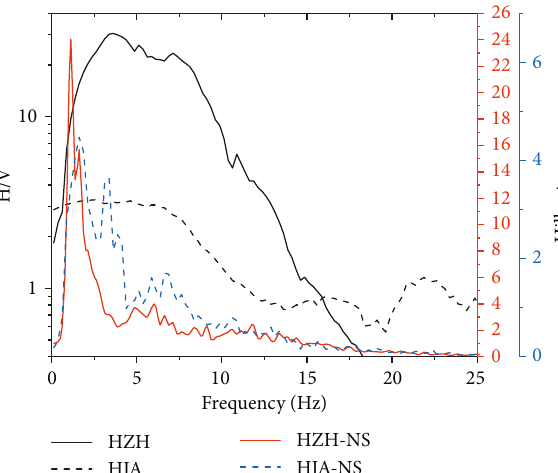
Figure 11: Marginal spectrum and HVSR results.